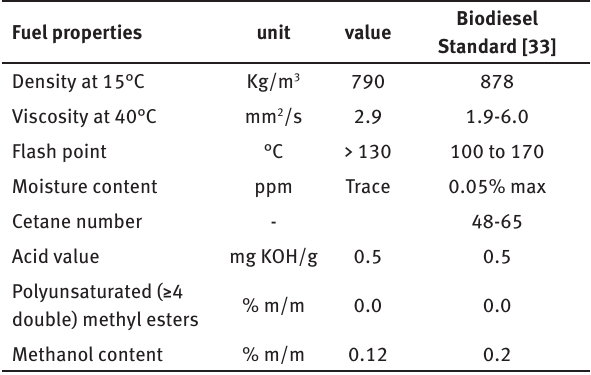
Table 5: Characterization of the Biodiesel from WCOs. Fuel